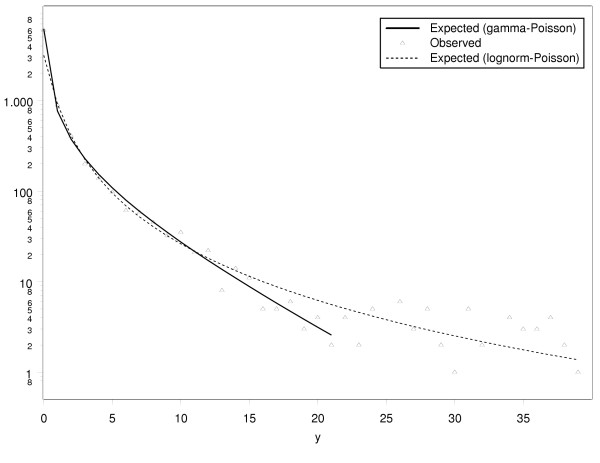
Frequency of SAGE counts (restricted to genes mapped to a single tag) of library N225.111k, versus the expected frequencies on the basis of the untruncated model with non-parametric component for high-expressed tags. Compared to the expected frequencies in the truncated lognorm-Poisson-model.